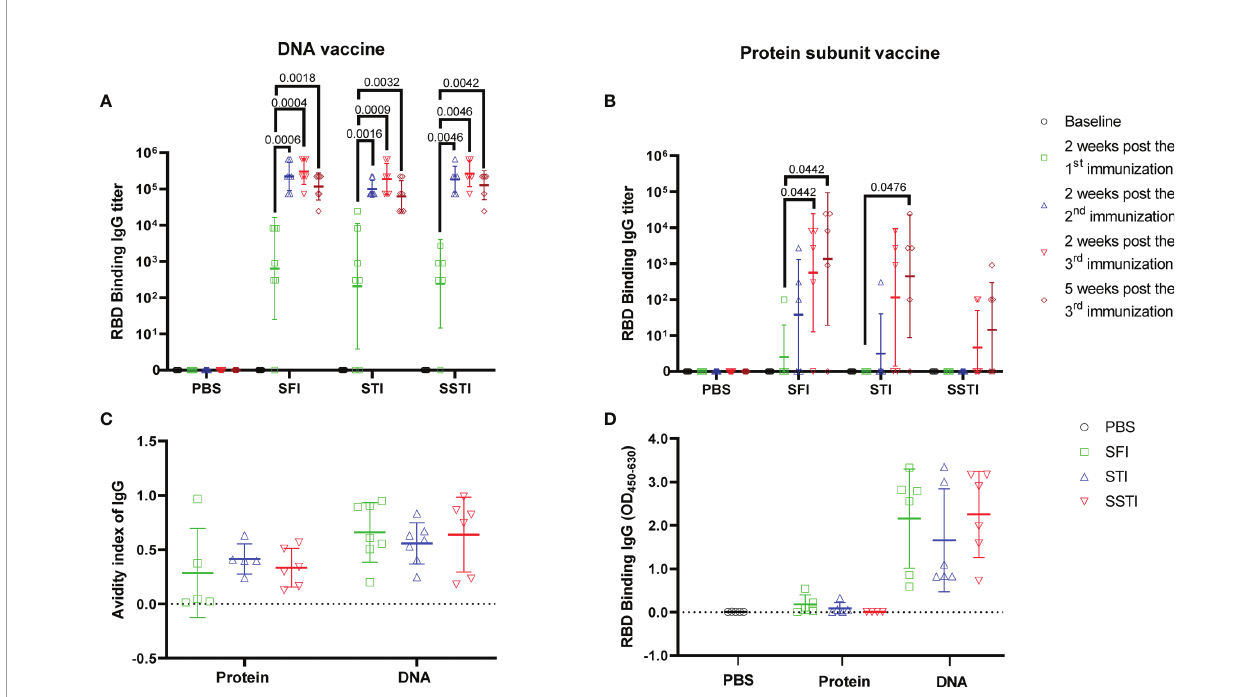
FIGURE 2 | SSTI did not improve the speci fi c antibody responses elicited by the DNA or the protein subunit vaccine. RBD binding antibody titers elicited by the DNA (A) or the protein subunit vaccine (B) were determined at baseline, 2 weeks post the 1 st immunization, 2 weeks post the 2 nd immunization, 2 weeks post the 3 rd immunization and 5 weeks post the 3 rd immunization, respectively. (C) The avidity of RBD-speci fi c antibodies was determined at 5 weeks post the 3 rd immunization. (D) RBD speci fi c IgG in BALF was detected using an ELISA method after adjusting the total protein for each BALF sample to the same concentration (250 m g/ml). Data are shown as mean ± SD. Statistical analyses were performed using the method of